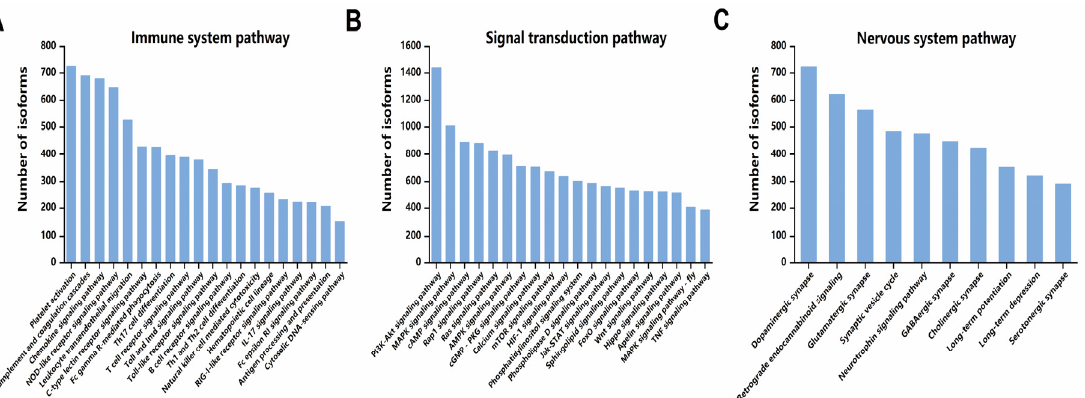
Figure 5. Participation of isoforms in various pathways. ( A ) The proportion of isoforms annotated in the Immune system pathway. ( B ) The proportion of isoforms annotated in the signal transduction pathway. ( C ) The proportion of isoforms annotated in the nervous system pathway.